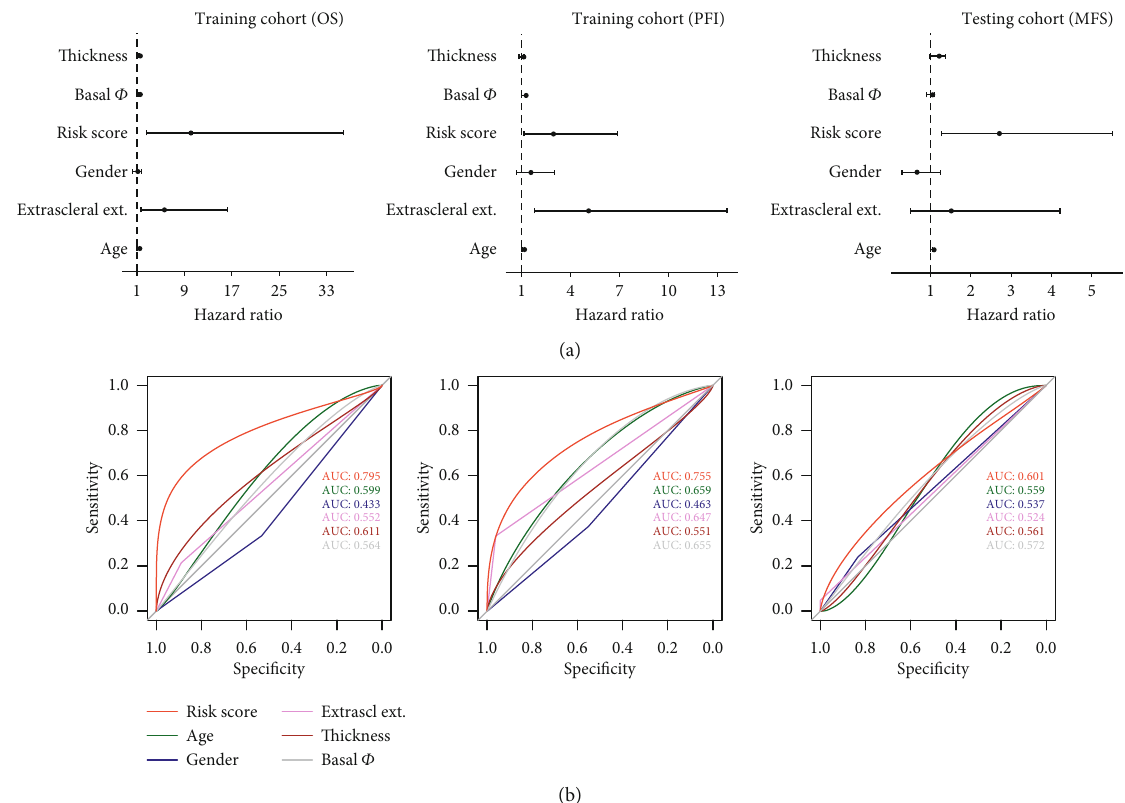
Figure 4: Forest plot summary of univariate Cox analysis of created score ’ s prognostic value (a) and receiver operating characteristic (ROC) analysis of the sensitivity and speci fi city of the prognosis prediction score (b) in training cohort (overall survival), training cohort based (progression-free interval), and testing cohort based (metastasis-free survival). Additional clinical and pathologic parameters such as age, gender, tumor thickness, basal tumor diameter, and extrascleral extension were included as a